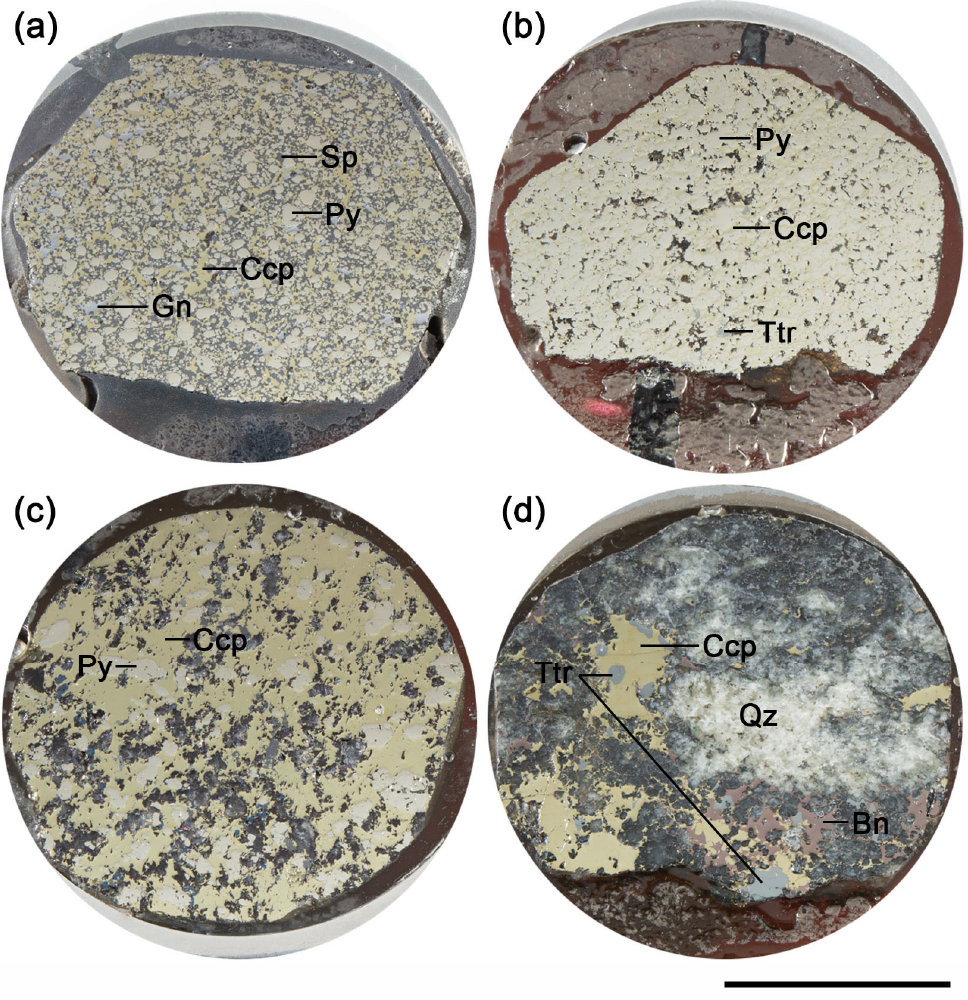
Figure 4. Macrophotographs of the representative mineral assemblages of the mineralizations in the Fundu Moldovei: pyrite-polymetallic type with subhedral pyrite grains cemented by sphalerite, chalcopyrite and galena ( a ); pyrite copper type with subhedral pyrite grains cemented by chalcopyrite and tetrahedrite ( b ); compact copper type with compact chalcopyrite with anhedral inclusions of pyrite and quartz ( c ); and precompact quartz-copper type with quartz that includes anhedral grains of chalcopyrite, tetrahedrite, and bornite ( d ). Sp—sphalerite; Py—pyrite; Ccp—chalcopyrite; Gn—galena; Ttr—tetrahedrite; Qz—quartz; Bn—bornite. Scale bar—1